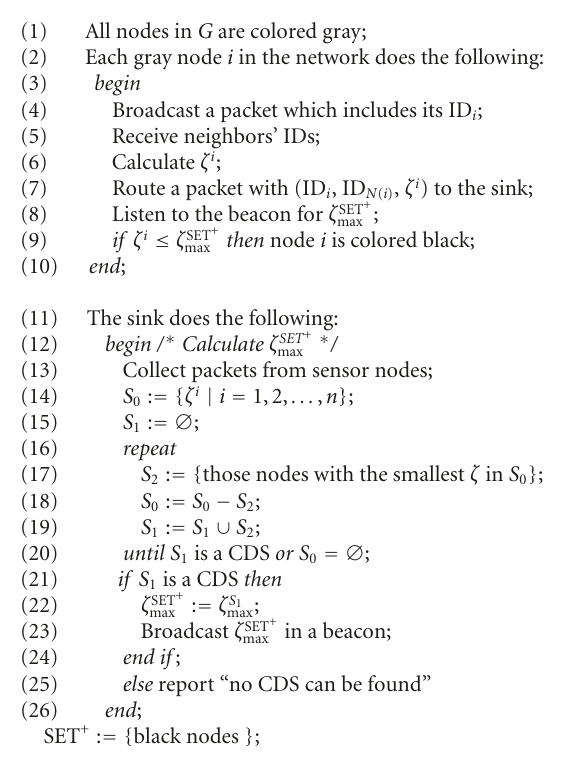
Algorithm 3: SET + finding